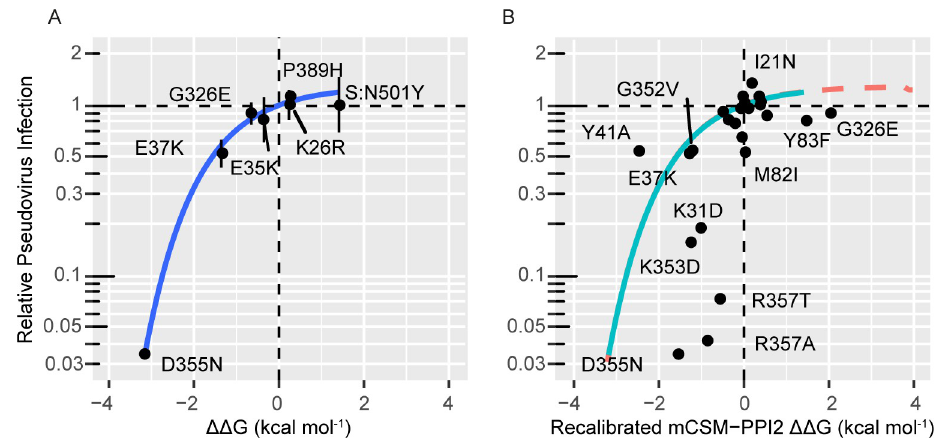
Fig 7. The relationship between experimental and predicted ΔΔ G of ACE2 mutants and relative SARS-CoV-2 pseudotype infectivity reported by Shukla et al [38]. A. Pseudotype infectivity is strongly correlated with experimental ΔΔ G and fits well to a negative exponential model ( y = a (1 − e − cx ); a = 0.25, p = 0.05; c = 0.84, p = 0.0007), which is in line with the mechanism proposed by Hasegawa et al. for other enveloped viruses [33], where there is an cell specific affinity threshold for infection beyond which infectivity does not increase. To extend the dataset we have included the affinity [28] and infectivity [38] data for the Spike N501Y variant. n.b. ACE2 p.Asp355Asn did not bind Spike RBD in our experiments and we have imputed this result with the calculated upper bound based on the detection limits of the assay. B. Pseudotype infectivity is also associated with recalibrated mCSM-PPI2 predicted ΔΔ G (Spearman ρ = 0.69, p = 0.0003), this is a stronger association than reported by Shukla et al. [38] who compared infectivity to Procko and co-workers [22] deep mutagenesis binding data (Spearman ρ = 0.51). The model derived from the regression of pseudotype infectivity against experimental ΔΔ G is overlayed for comparison; the region that is extrapolated beyond the range of the experimental ΔΔ G data is indicated by the red dashes.